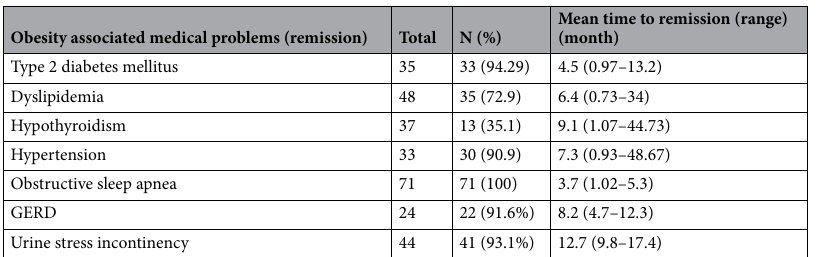
Mean time to remission (range) (month)